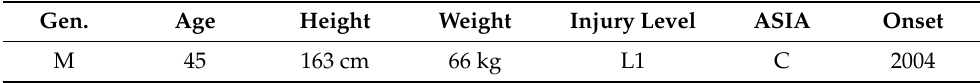
Table 3. Characteristics of the patient with an incomplete spinal cord injury (SCI). Gen.